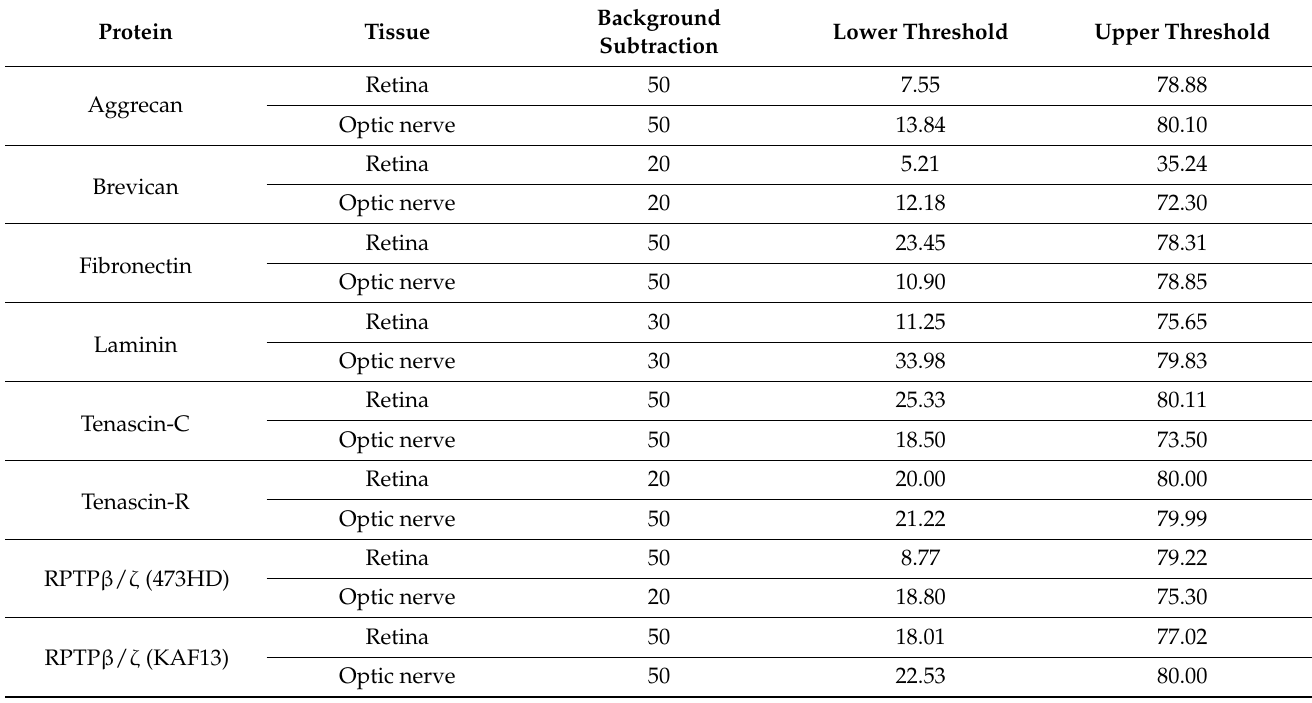
Table 3. Adjustments for the ImageJ macro. Background subtraction data and the upper and lower threshold values for determining the stained signal area